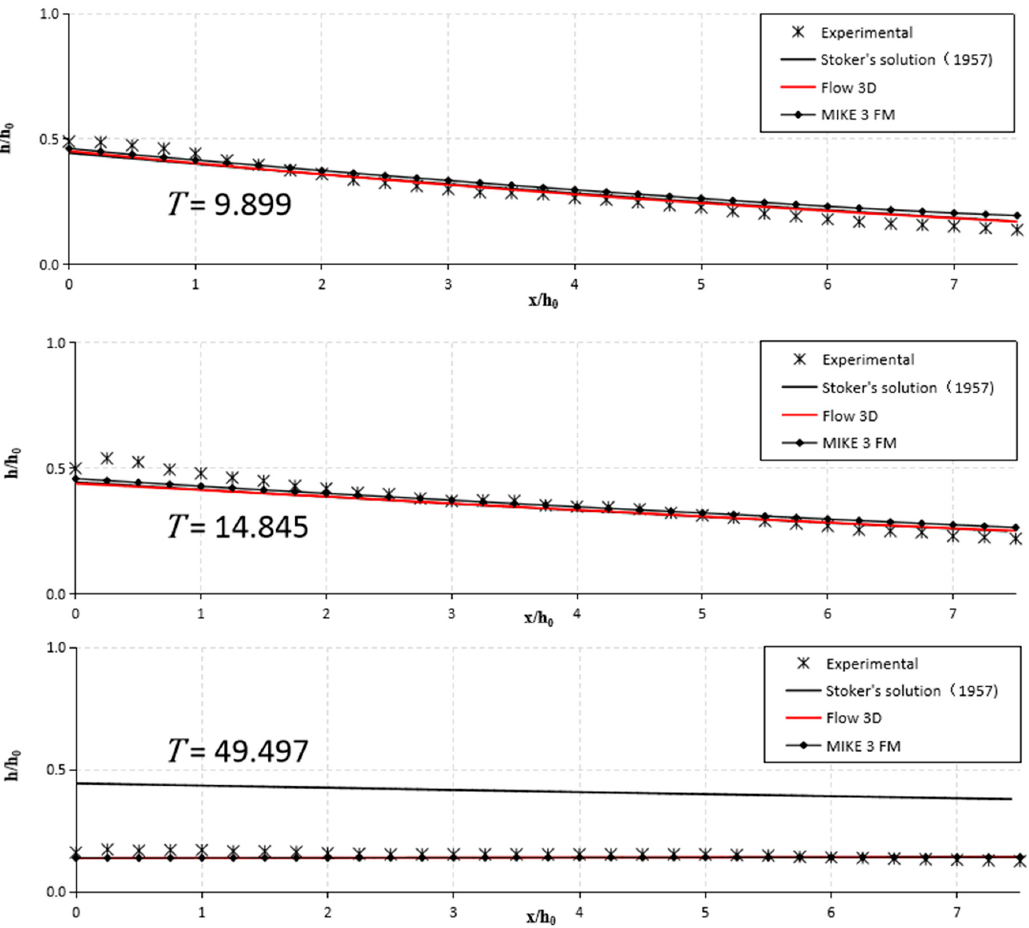
Figure 9. Experimental and numerical comparison of free surface profiles h / h 0 ( x / h 0 ) during late stages at various dimensionless times T after the failure in the dry-bed by Khankandi et al. [39]. Table 1. RMSE values for the free surface profiles observed by Ozmen-Cagatay and Kocaman